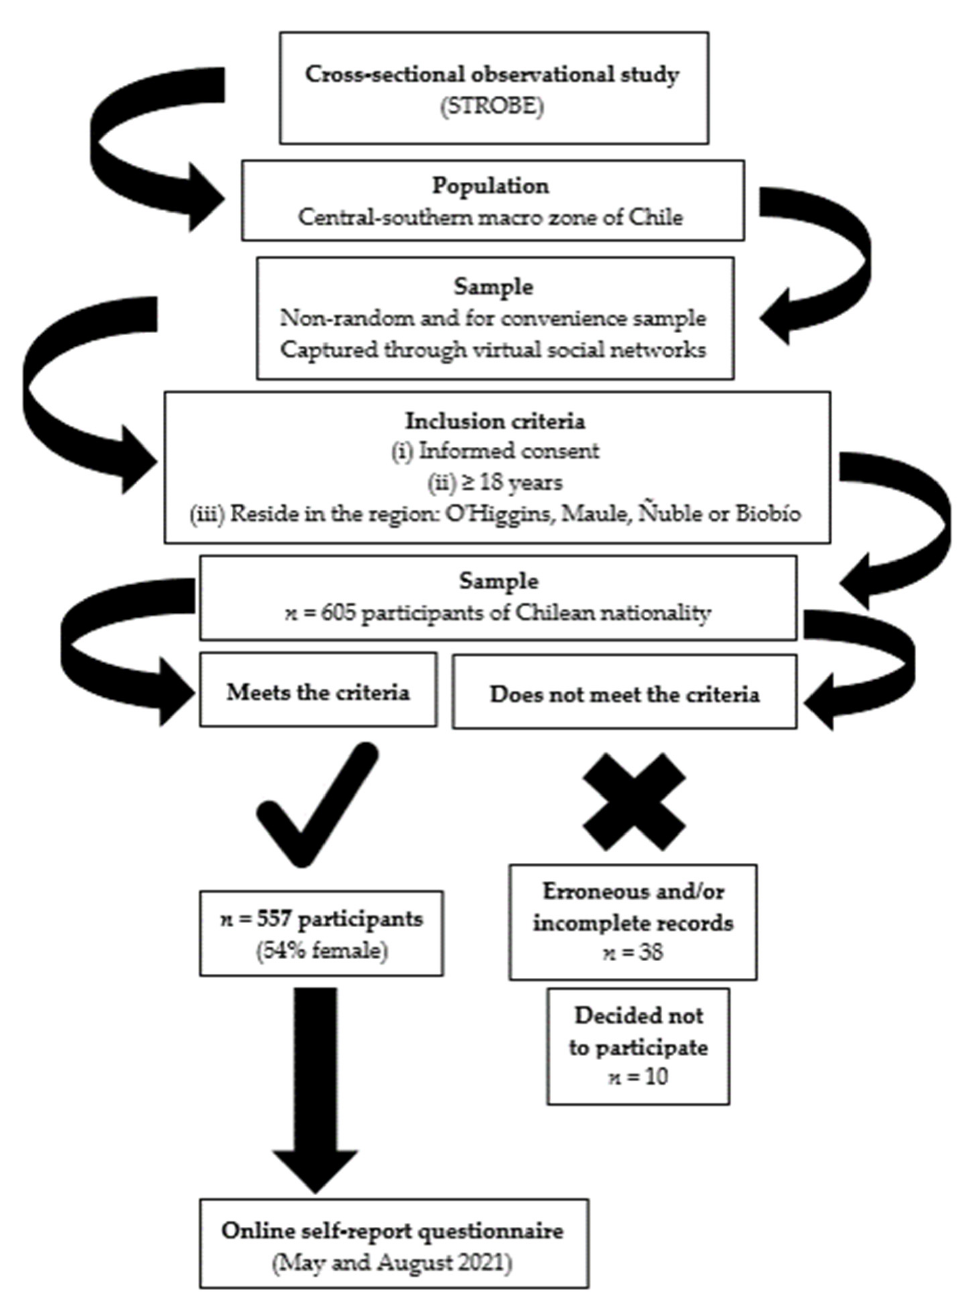
. V O 2 max was classified according to sex and age [39] into two categories: The relative form of “very low, low, or normal” or “good, excellent, or superior”.